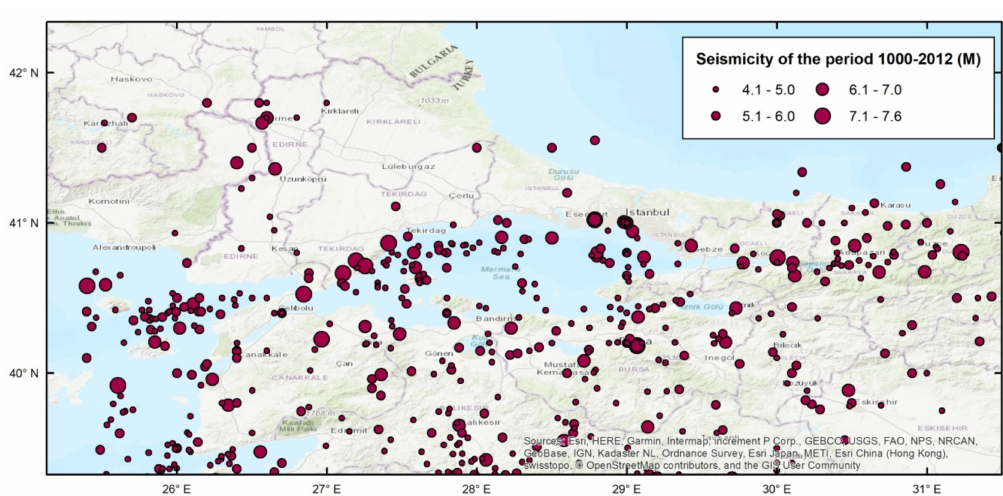
Figure 5. The earthquake catalogue of the region for the period 1000 AD to